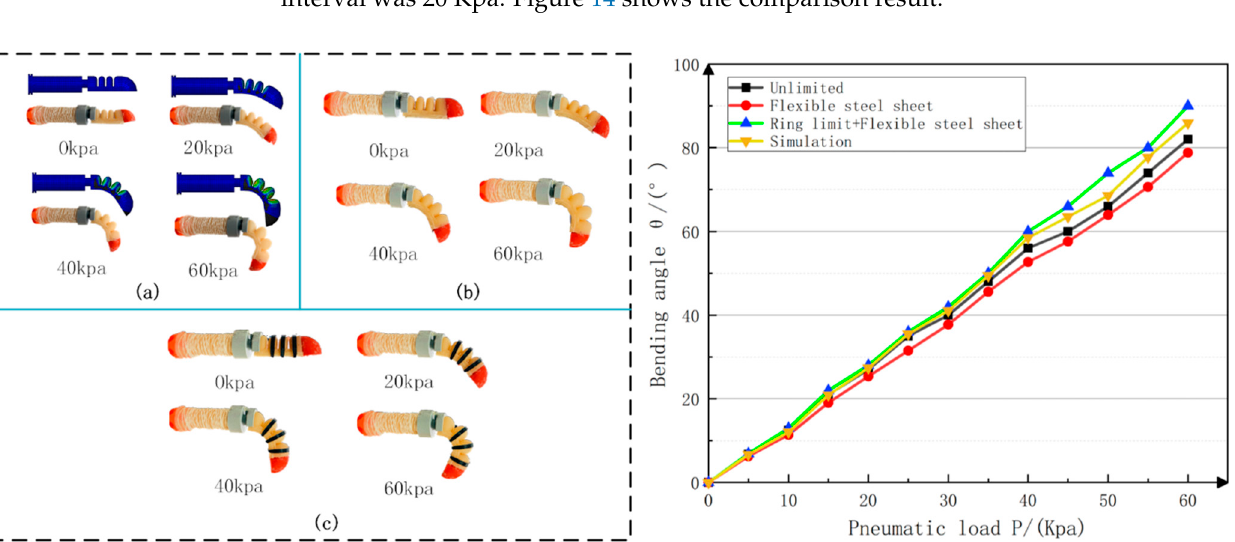
Figure 13. Thumb distal phalanx joint bending experiment: ( a ) External loads are applied to the upper chamber; ( b ) External loads are applied to the lower chamber; ( c ) External loads are applied to the left chamber; ( d ) External loads are applied to the right chamber.